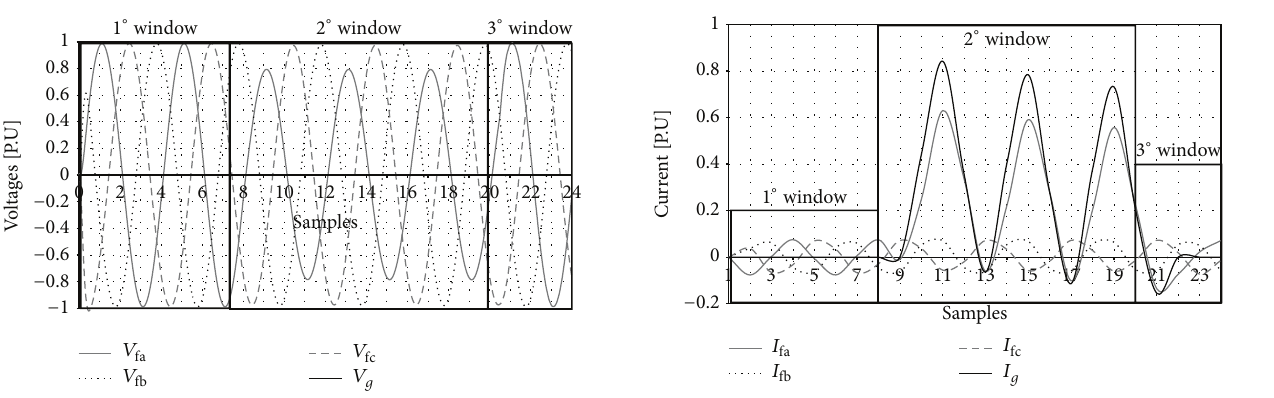
the transmission line. The last four columns represent the type of fault in a binary way, which is referred to, in this case, as a phase A to ground